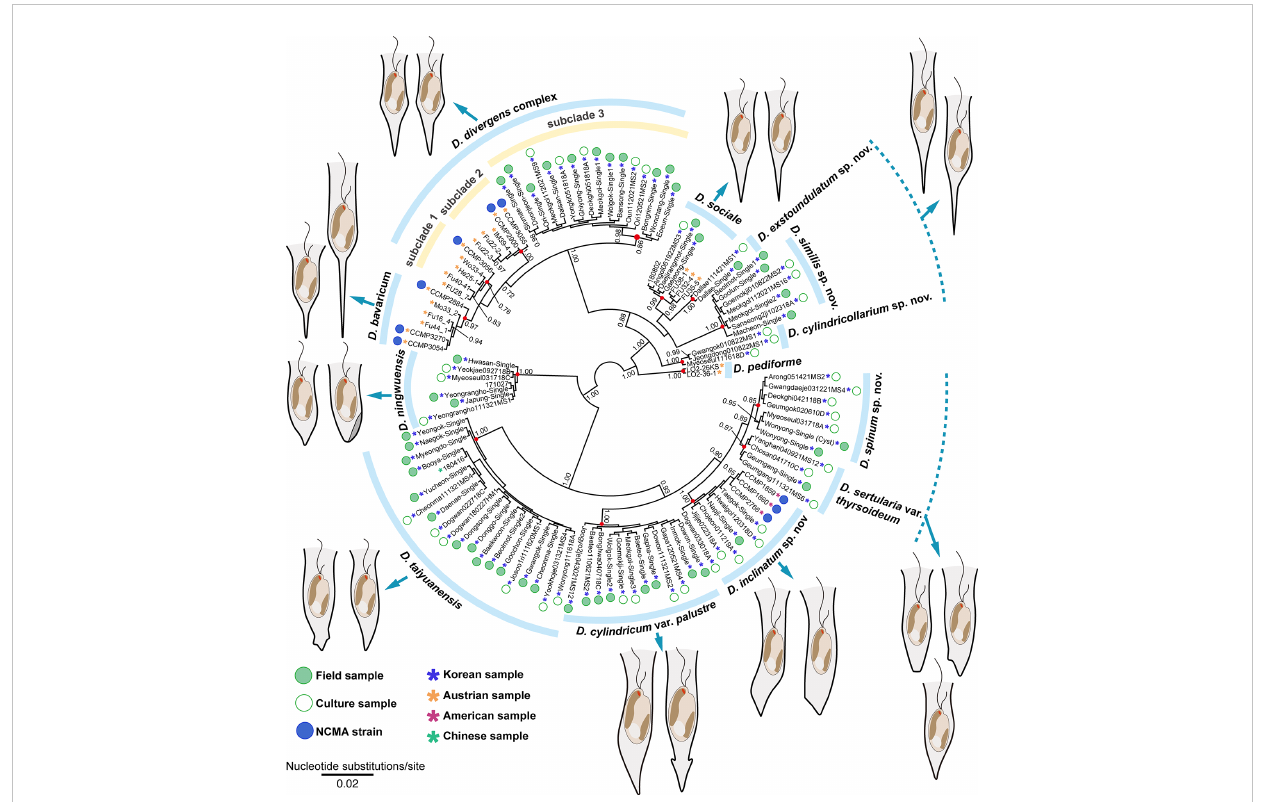
FIGURE 1 Bayesian tree of the genus Dinobryon based on nuclear encoded ITS sequences. Bayesian posterior probabilities (PP, right) are shown at each node. The node of each species-level lineages is indicated by red circles; the scale bar indicates the number of substitutions/site; (-) denotes values < 0.70 for